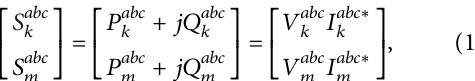
R R � resistance of phases a , b , and c L L � mutual inductance between phases a and b , phases b and ab , bc , and ca V b V c � bus voltage of phases a,b, and c at bus m ; m , m , and m I b I c � current of phases a,b, and c injected at bus m m , m , and m